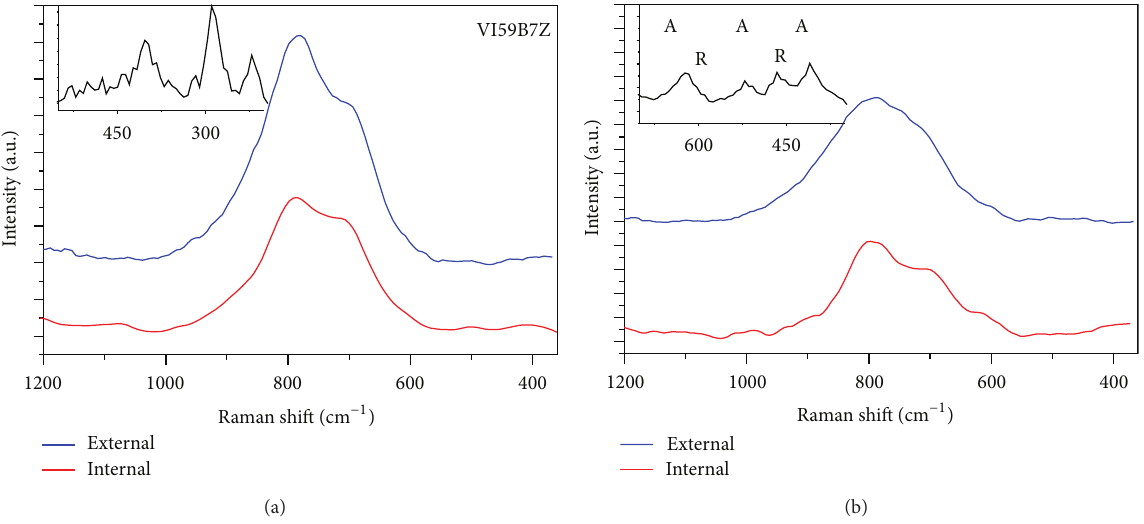
Figure 4: Raman spectra of the external and internal surface of samples VI59B7Z (a) and VII59B11. The inset in the (a) section is an enlarged view of the external surfaces of sample VI59B7Z. The inset in the (b) section reports the Raman spectrum form the cross section of sample VII59B11. The peaks are identified as TiO 2 in the anatase (indicated with A) and rutile phase